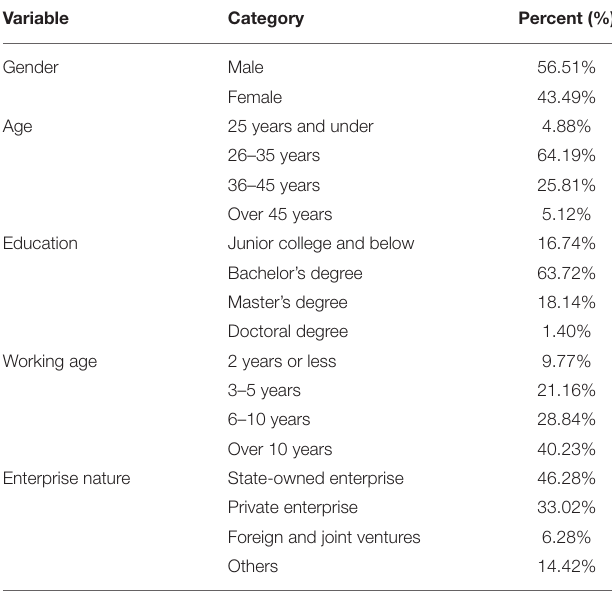
TABLE 1 | Basic characteristics of 430